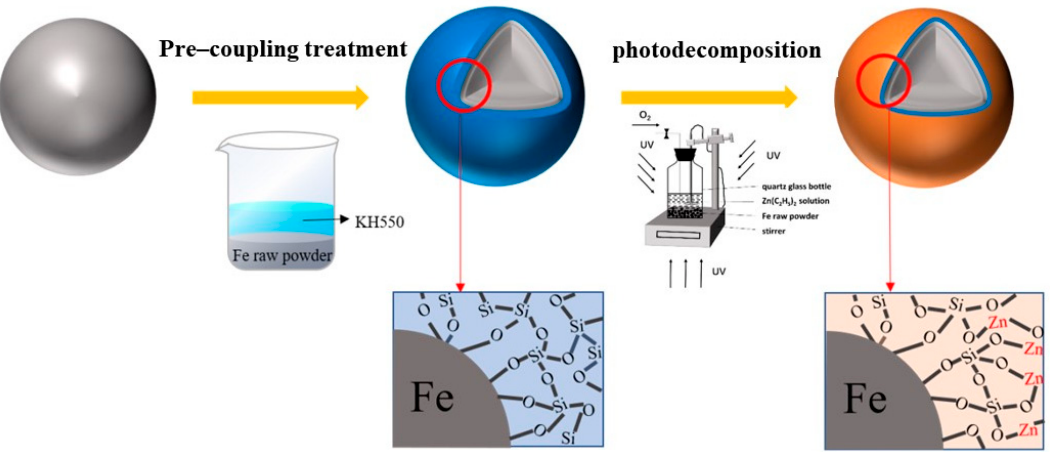
Figure 6. Schematic diagram of Fe@Zn-O-Si prepared using the pre-coupling and photodecomposi- tion treatment.